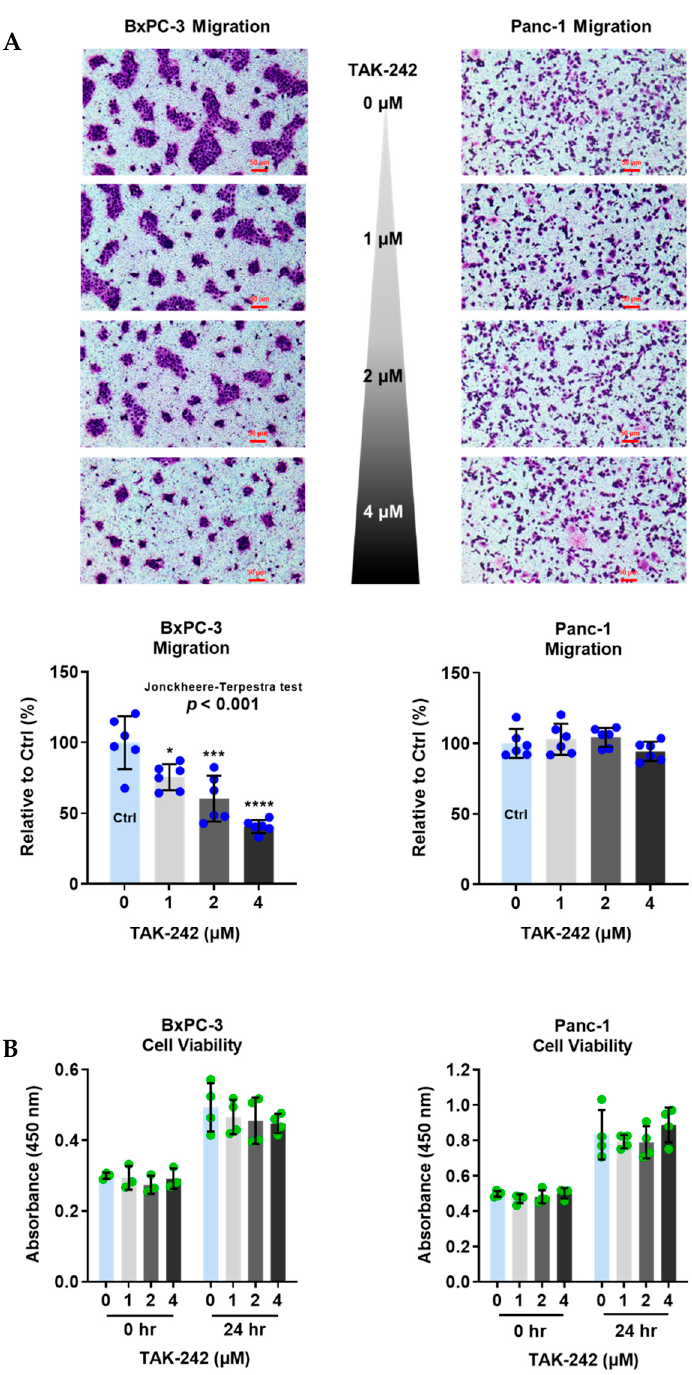
Figure 2. TLR4 inhibitor (TAK-242), at non-cytotoxic concentrations, reduces migration of pancreatic cancer cells expressing high level of TLR4 (BxPC-3). ( A ) Migration of BxPC-3 and Panc-1 cells, and ( B ) cell viability of BxPC-3 and Panc-1 cells measured after treated with TAK-242, a specific TLR4 inhibitor, at different concentrations for 24 h. Migration was presented as % of control, and cell viability was determined using WST-1 assay. Data are represented as mean ± SD from multiple replicates. The Jonckheere-Terpstra test was conducted to indicate the trend of cell migration’s change with increasing TAK-242 concentration after a significant multiple comparisons test (* p < 0.05, *** p < 0.001, **** p < 0.0001, compared to control, obtained from one-way ANOVA and post-hoc multiple comparisons with Dunnett correction). Scale bars, 50 µm.